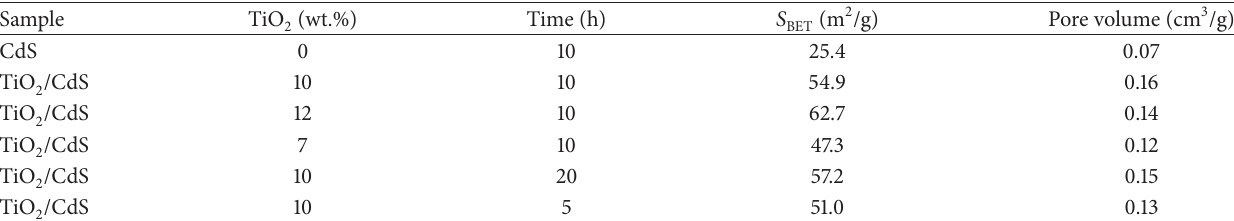
Table 1: BET surface area and pore volume of the as-synthesized